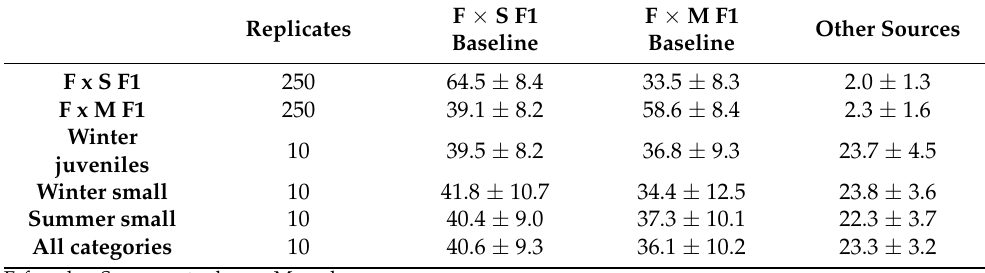
Table 5. Assignment distribution (%) and standard deviation of A. antennatus female commercial categories to simulated offspring from 2015 spawner genotypes.